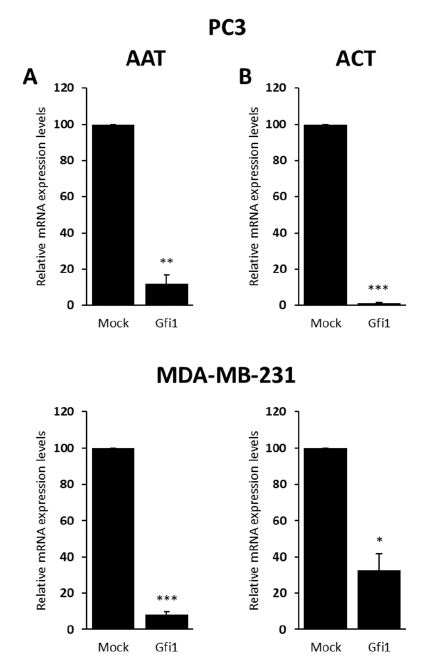
Figure 4. Analysis of expression of Gfi1 target genes in PC3 and MDA-MB-231 cell lines. QRT-PCR showing the mRNA expression levels of AAT ( A ) and ACT ( B ) in empty vector and Gfi1-transfected PC3 and MDA-MB-231 cells. Gfi1 re-expression reduces AAT and ACT in both cell lines. Data shown represent the mean ± s.e.m. of three independent experiments completed in triplicate. * p < 0.05, ** p < 0.01, *** p < 0.001